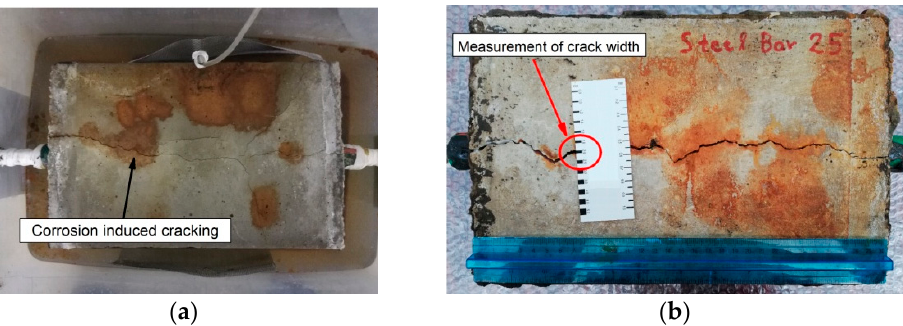
Figure 4. ( a ) Cracking development on concrete surface during accelerated corrosion test. ( b ) Map- ping and measurement of surface crack width due to corrosion.